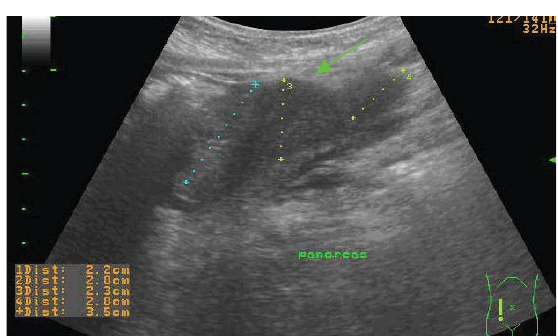
Figure 2. Abdominal echography scan 15 days after admission showing peripancreatic hypoechogenic masses